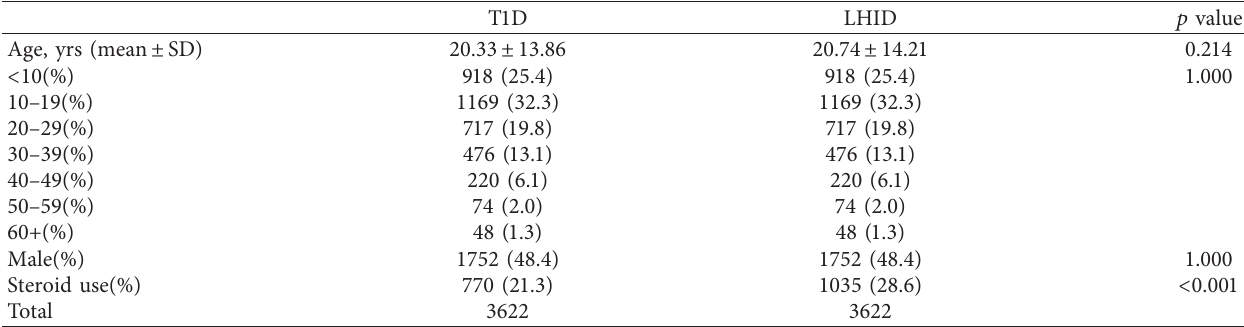
Table 2: The hazard ratio (HR) of cataracts between the type 1 diabetes (T1D) group and the Longitudinal Health Insurance Database (LHID) group stratified by age of enrollment and gender. The younger T1D group had a higher HR of cataracts.